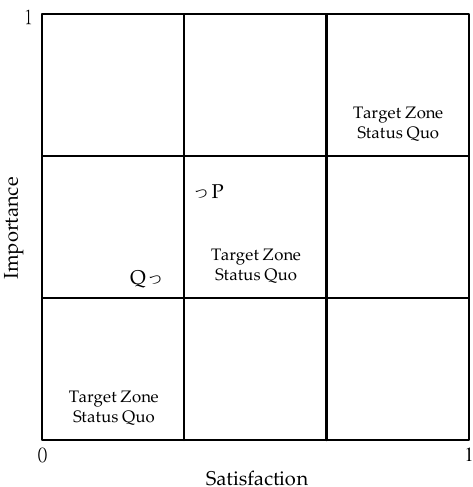
Figure 1. Performance Evaluation Matrix (PEM) [28]. P: status quo zone; Q: improvement zone.